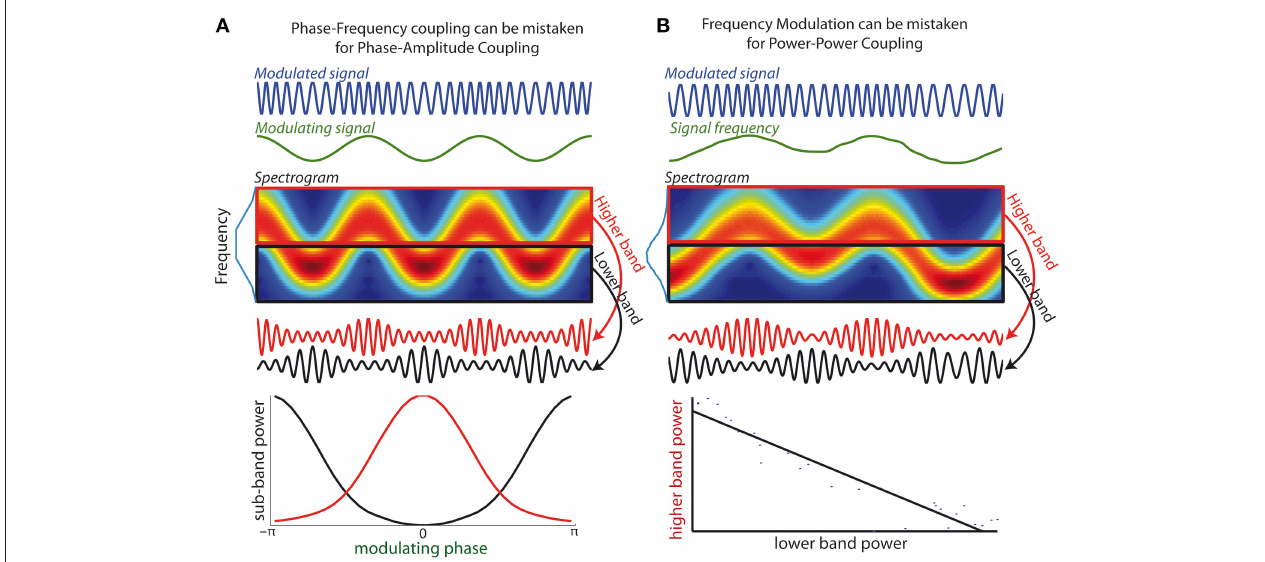
FIGURE 2 | (A) Phase-Frequency coupling can be mistaken for Phase-Amplitude Coupling. (Top curves) An oscillatory signal (blue) whose frequency is modulated by an oscillatory signal of lower frequency (green), i.e., a canonical example of phase-frequency coupling. (Middle-upper panel) The spectrogram shows how energy of the modulated signal fluctuates between higher and lower frequency sub-bands. Blue line along the y-axis depicts the signal spectrum. (Middle lower panel) Two bandpass filters are applied onto the modulated signal to extract a higher band component (red curve) and a lower band component (black curve). The amplitude of both components is modulated as the signal frequency enters in and out of the respective frequency bands. (Lower panel) Spurious positive test for phase-amplitude coupling: the amplitude of both sub-bands components is determined by the phase of modulatory signal (the peak amplitudes of both components are in antiphase). (B) Frequency Modulation can be mistaken for Power-Power coupling. (Top curve) An oscillatory signal whose frequency evolves across time. (Middle-upper panel) The spectrogram shows how energy of the signal evolves over time between frequency sub-bands. (Middle-lower panel) When components are extracted from two neighboring frequency bands, the power of the two resulting signals fluctuates in opposite fashion. (Lower bottom panel) Spurious positive test for power-power coupling between the two frequency bands: the interpolated line shows strong anti-correlation of the power of the two sub-band